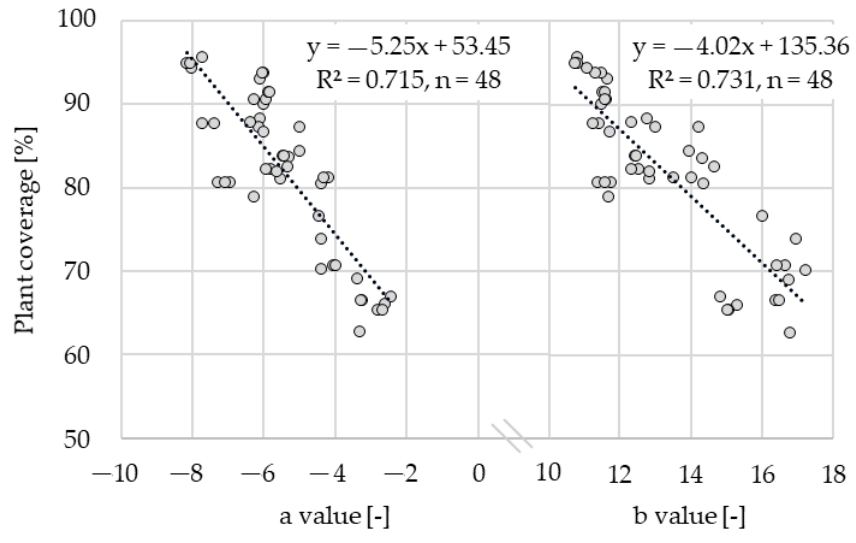
Figure 8. Linear regression models of plant coverage with mixed area reflectance values of a ( p = 4.0003 × 10 − 14 ) and b channel ( p = 1.0449 × 10 − 14 ) in the growth stages BBCH 32, 39, and